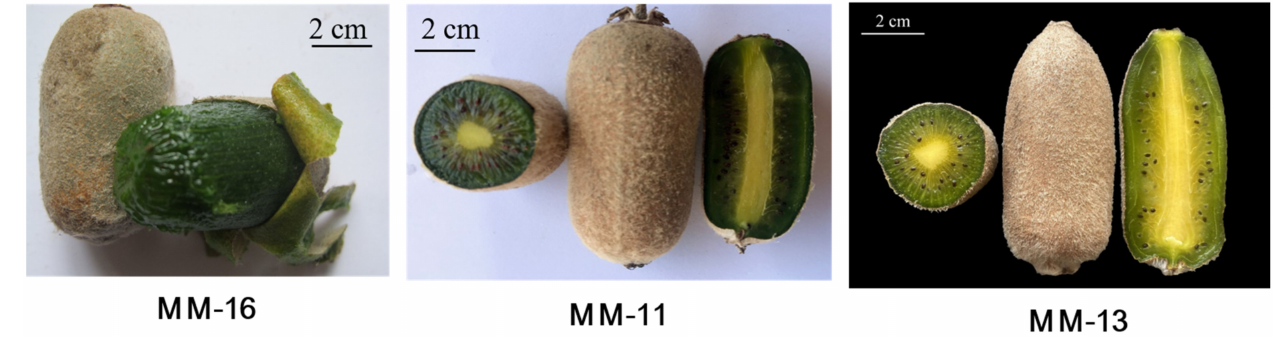
Figure 1. Fruit phenotypes of ‘MM-11’, ‘MM-13’ and